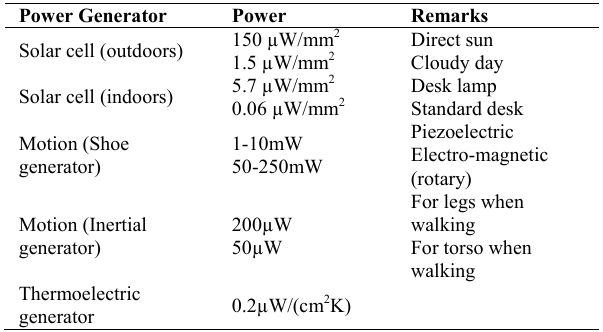
Table 1: A comparison of power generators useful for wearable Microsystems